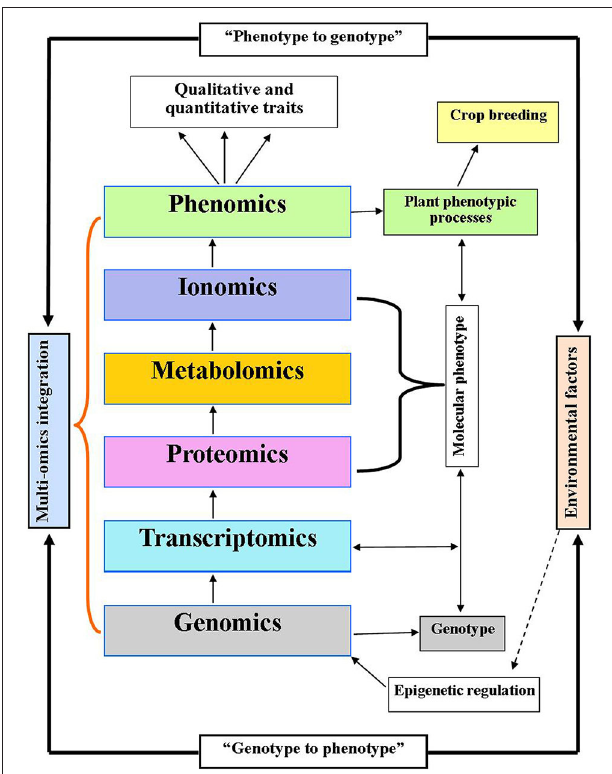
FIGURE 2 | Integration of multi-omics model linking genotype to phenotype and phenotype to genotype concept with systems biology. Genomics indicates the genotype which determines phenotype traits (crop breeding improvement) via transcriptome, proteome, and metabolome. While, proteome, metabolome, and ionome are supposed to be a molecular phenotype. Environmental factors may trigger the regulatory events through epigenetic regulation of